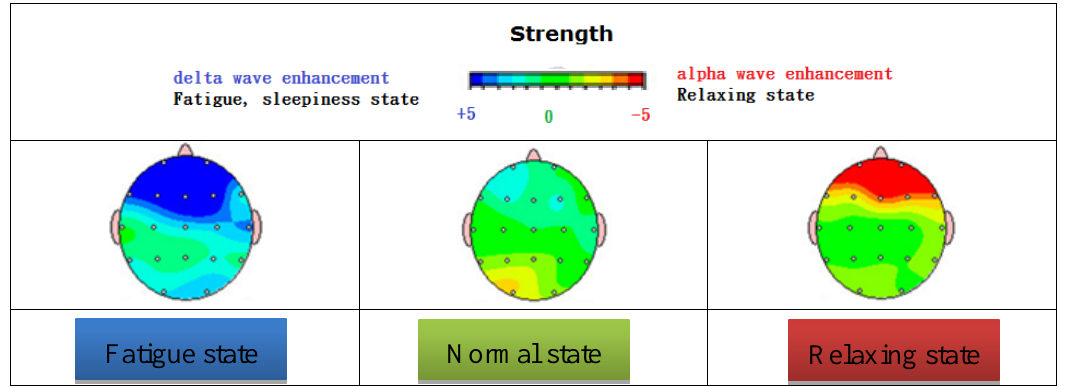
Figure 1. A BEAM map system based on various EEG